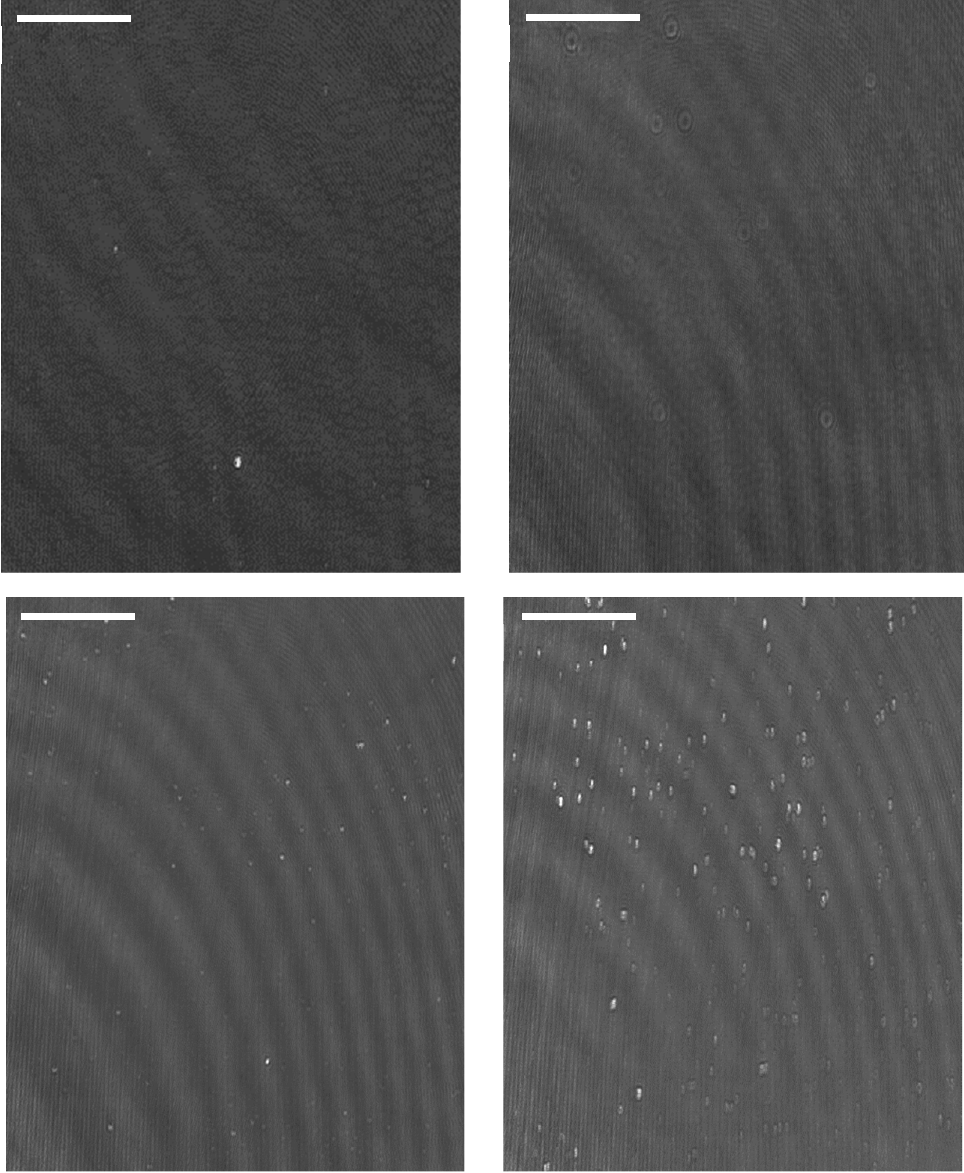
Figure 4. BAM images of a two component (GCB/palmitic acid (PA)) monolayer on water at various surface pressures—scale bar represents 100 μm; top left, top right, bottom left, bottom right: 1, 5, 10, 25 mN m −1 .